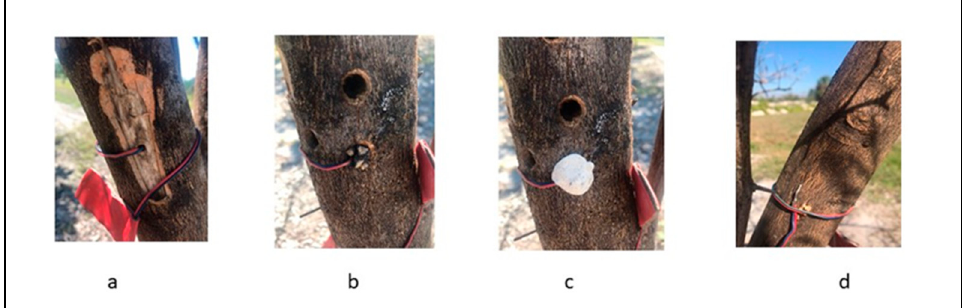
Figure 4. Installing thermocouples: ( a ) Drilling a hole and installing thermocouple inside the hole; ( b ) filling the gap; ( c ) dealing the hole; and ( d ) installing thermocouple on the surface.